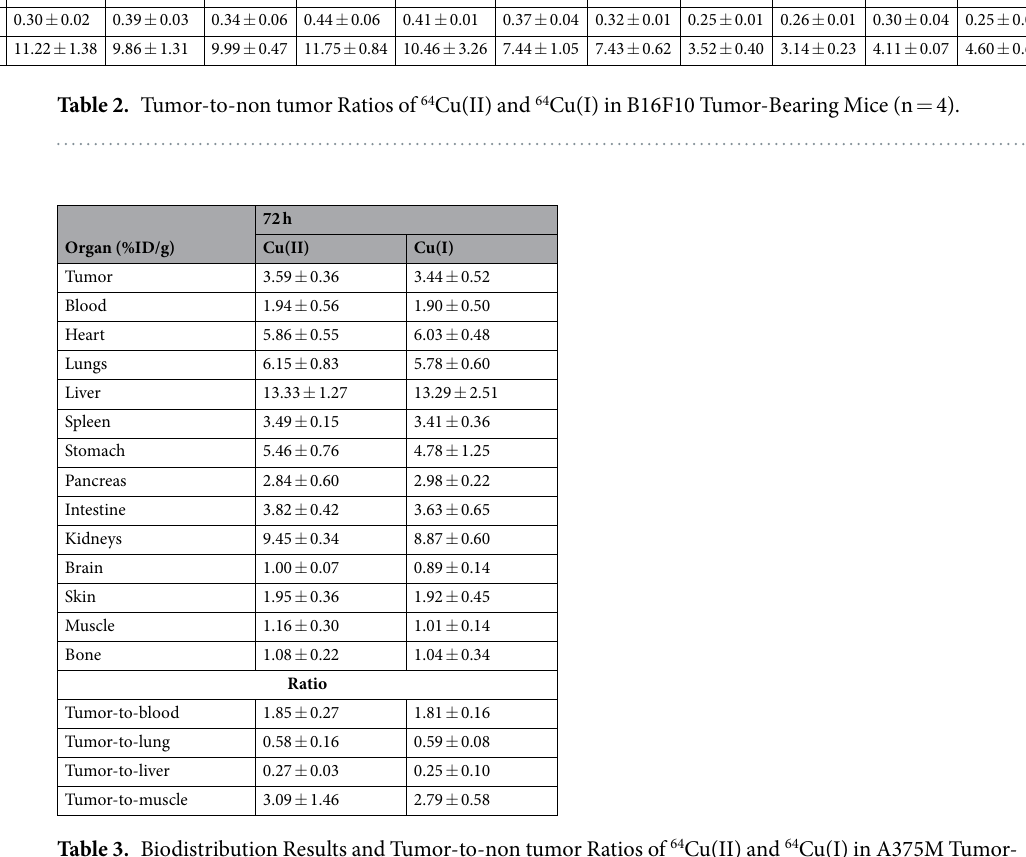
Table 3. Biodistribution Results and Tumor-to-non tumor Ratios of 64 Cu(II) and 64 Cu(I) in A375M Tumor- Bearing Mice (n =